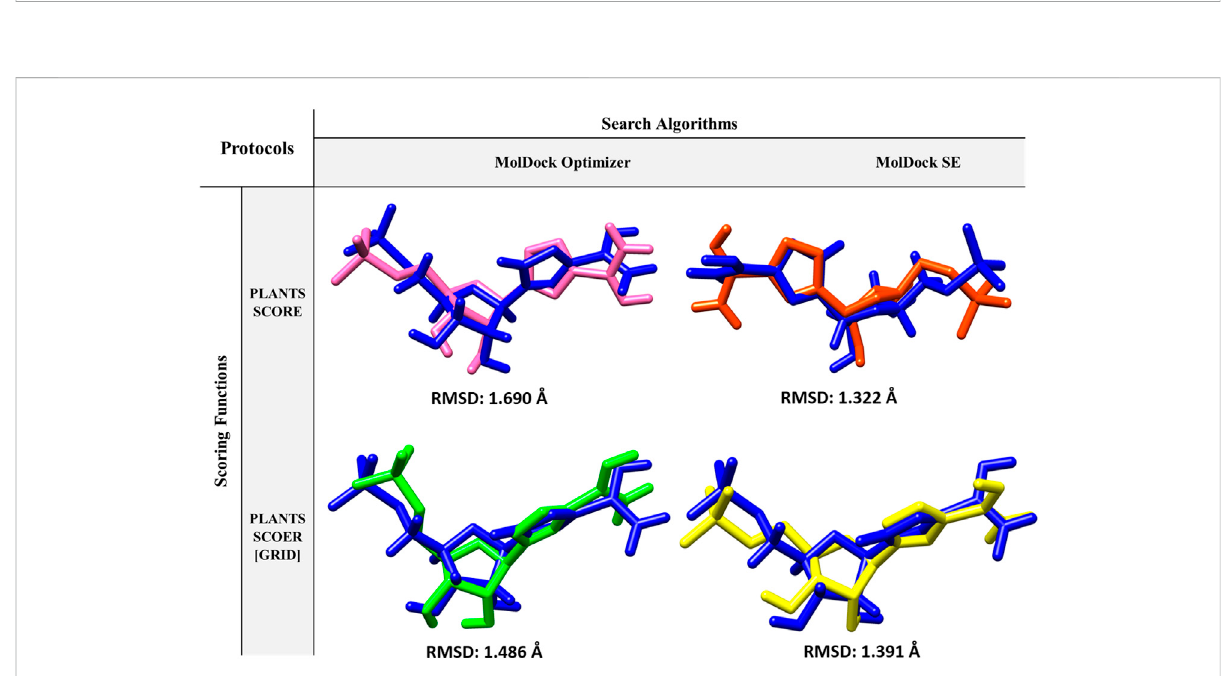
FIGURE 2 Protocols used in Re-docking to select the best search algorithm and scoring function for virtual